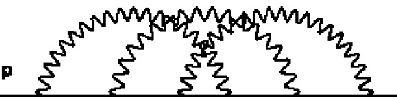
Figure 2. Triple-cross two-point